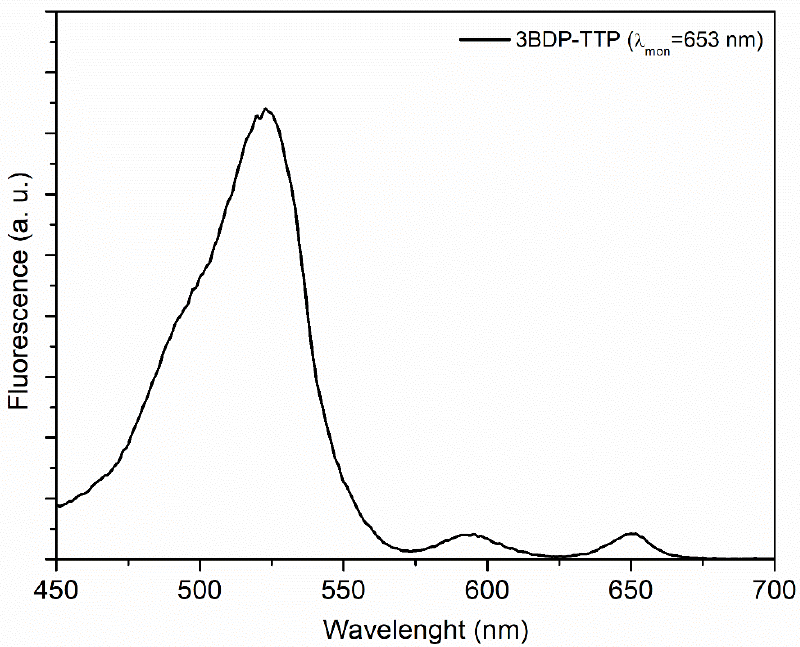
Figure 3. The excitation spectrum of 3BDP – TTP compound monitoring at the 653 nm wavelength.